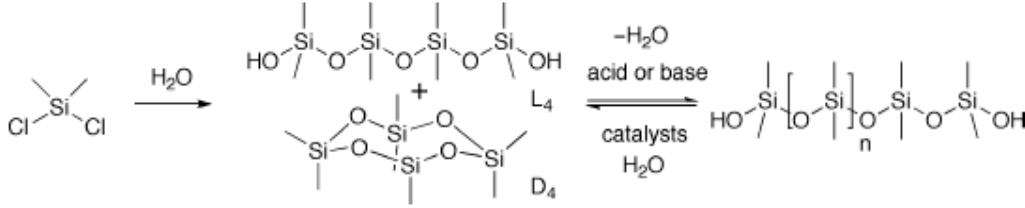
Figure 1. Conventional silicone hydrolysis polymerization synthesis route used in industry (Reproduced from Reference [2] with the permission).